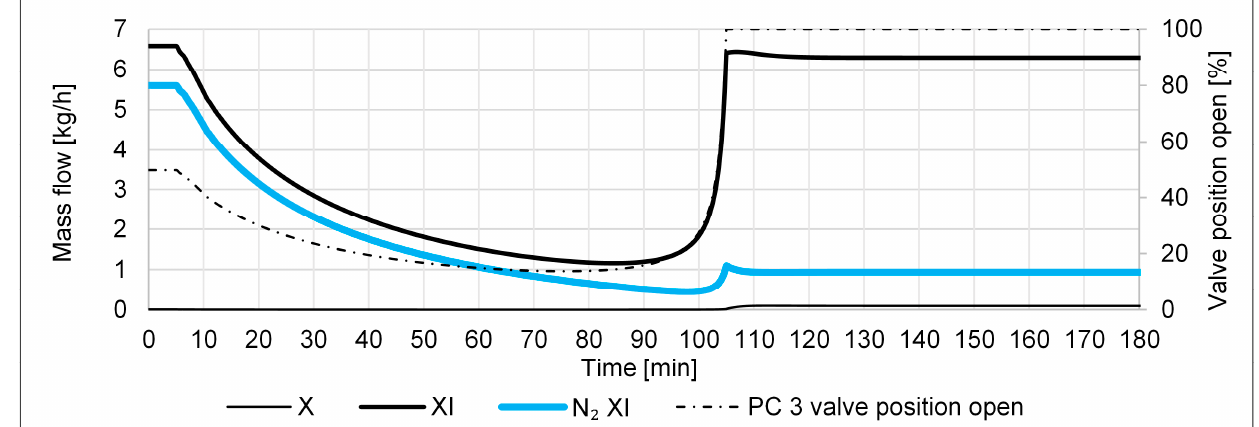
Figure 5 . Further mass fl ows and position of the recycle valve (right vertical axis) of scenario (b). Figure 5. Further mass flows and position of the recycle valve (right vertical axis) of scenario